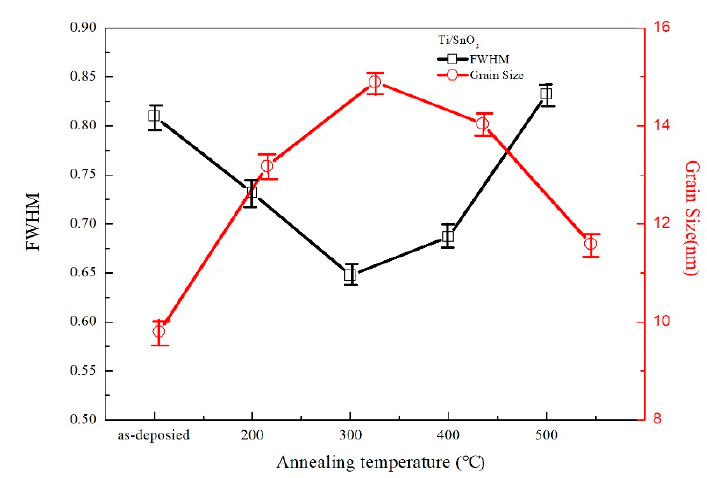
Figure 7. The full width at half maximum (FWHM) and grain size of as-deposited and annealed Ti:SnO 2 films . Ti:SnO 2 films.